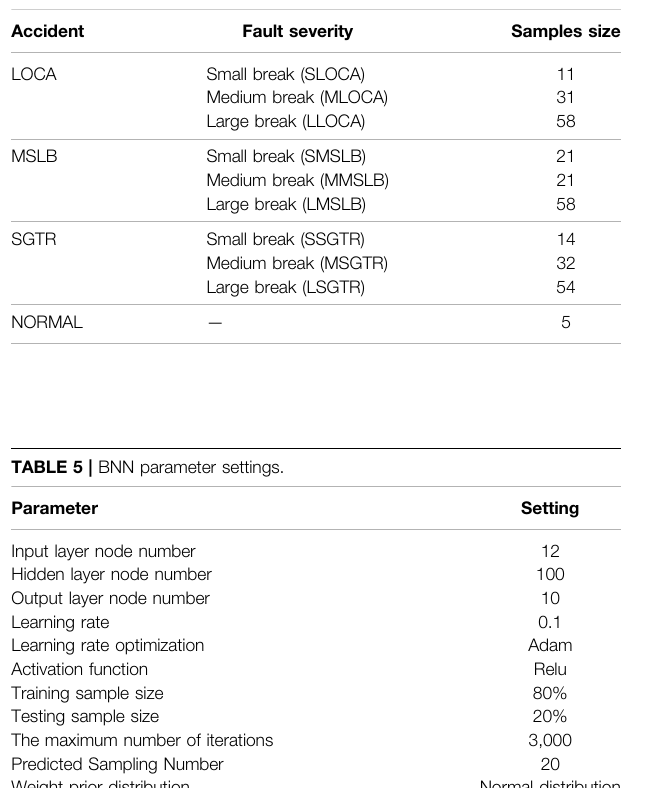
TABLE 4 | Overview of the data set.